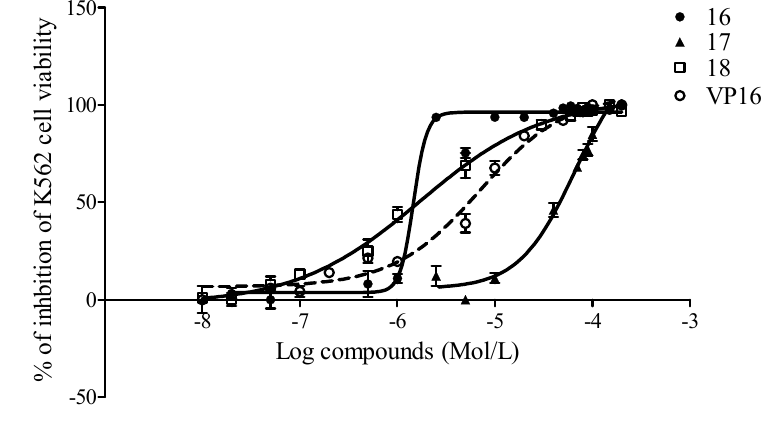
Figure 2. Dose-response profiles of compounds 16 – 18 and positive control VP16